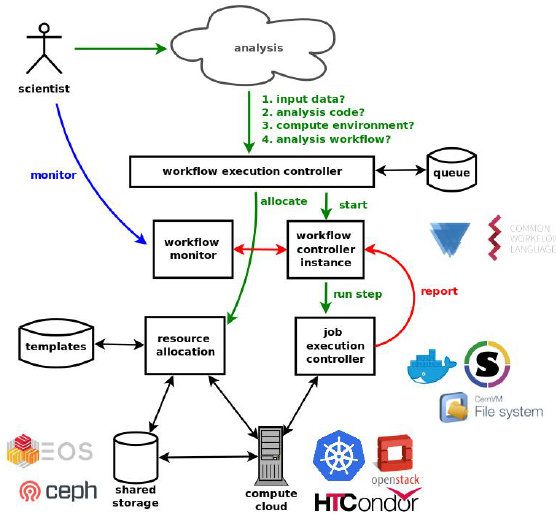
Figure 1 . The REANA system